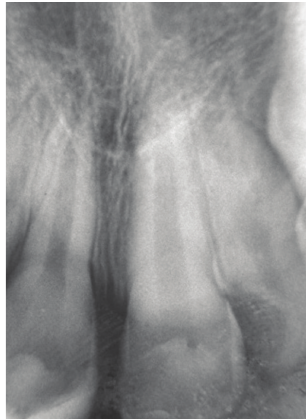
Figure 1: The initial periapical radiograph revealed the absence of fracture lines on the root structures, increased periodontal ligament spaces apically, or any radiolucent lesion in apical area of the injured incisors (first session; March 1998).